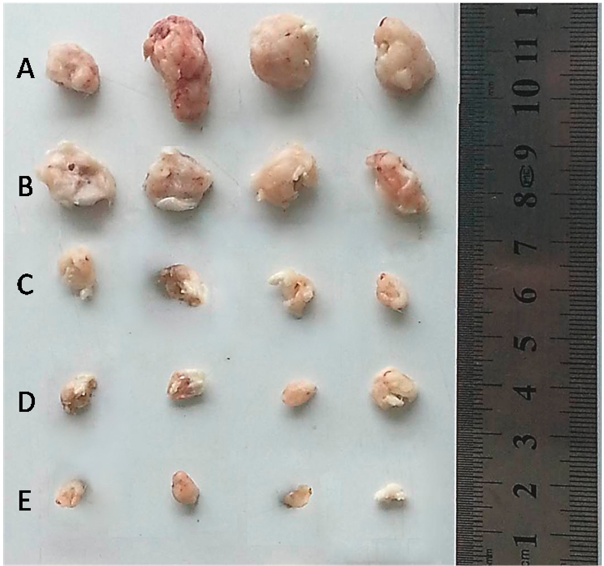
Figure 9. Tumors of each group treated with saline ( A ); black HA–GA/HA–His micelles ( B ); free DOX·HCl ( C ); DOX-loaded HA–His micelles ( D ); and DOX-loaded HA–GA/HA–His micelles ( E ) on the 14th